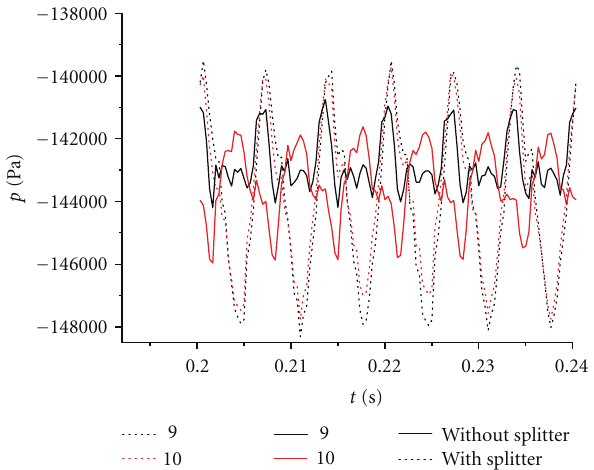
Figure 10: Time domain of pressure pulsation at outlet pipe monitoring points.